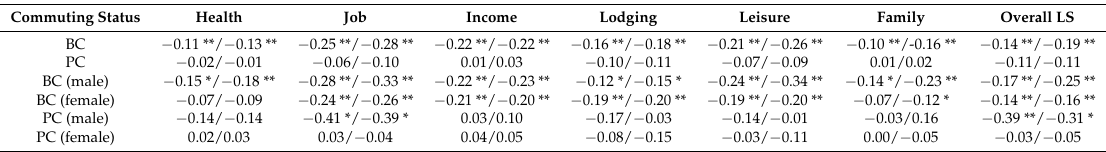
Table 4. Correlations between CSM (“Commuting stresses me”), ATC (“Attitude towards commuting”; 4 item scale), and life satisfaction